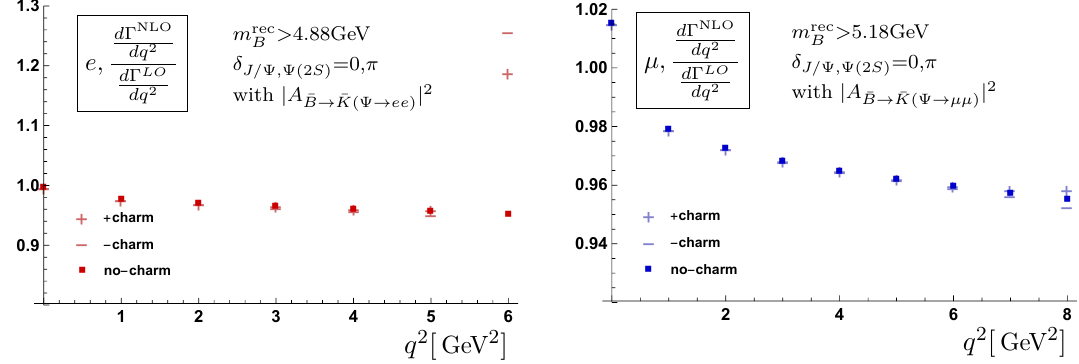
Figure 6 . Same plots as in figure 5 including resonant modes: (left) for electrons and (right) for muons respectively. It is noted that at q 2 = 6 GeV 2 , the effect is noticeable for electrons and care has to be taken (cf. main text). For the electrons, the plot ends at q 2 = 6 GeV 2 since beyond this value the effects are too large (at q 2 = (7 , 8) GeV 2 we find, approximately, (6 . 5 , 40) and (8 . 4 , 73) for +charm and -charm respectively). We have checked that resummation slightly tames the effect but qualitatively, it remains the same. The muon plot looks deceptively similar to the one in figure 5 for q 2 < 8 GeV 2 but differences arise thereafter. The corresponding plot without the LO normalisation can be found in appendix C in figure